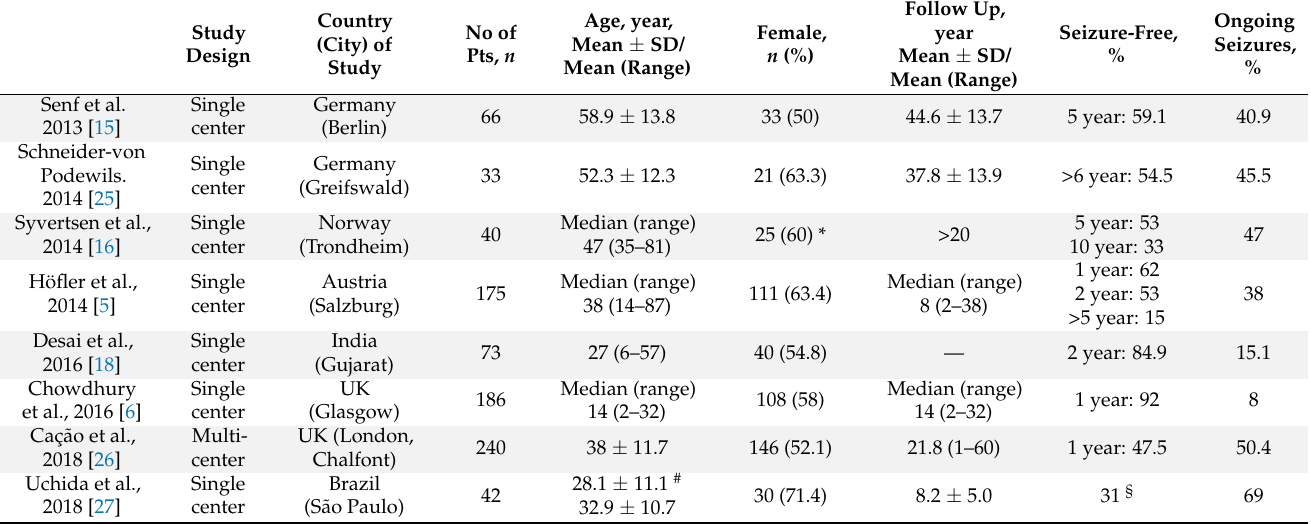
Table 5. Seizure outcome studies of JME in the last 10 years